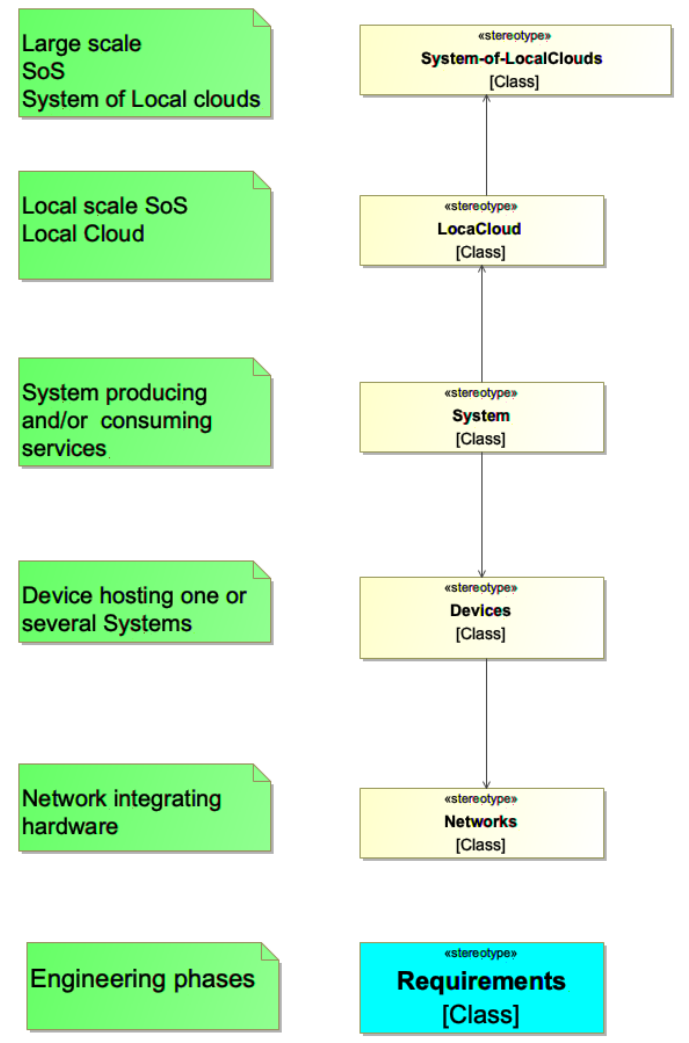
Figure 3. The SoS architecture applied in this paper, Eclipse Arrowhead. It addresses five levels from communication network and devices over microsystems and microservices enabling first level of scalability into individual local clouds and finally to large scalability considering system of local